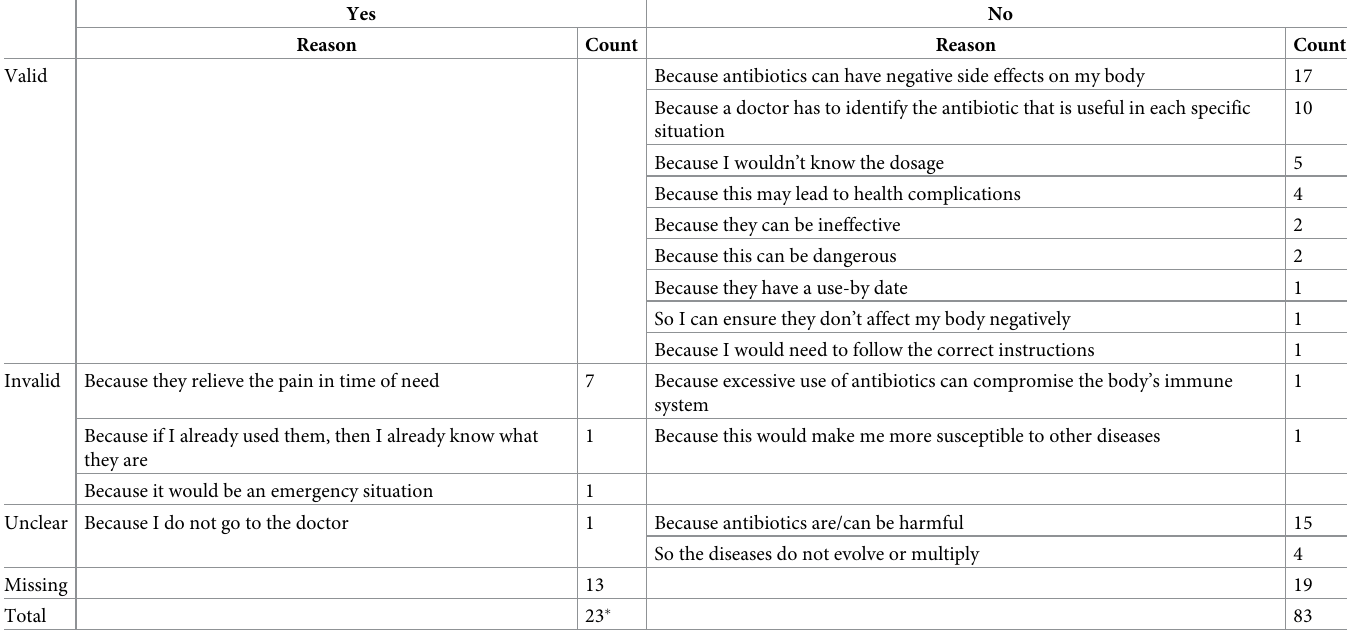
Table 3. Findings pertaining to Question 2: Would you take antibiotics without a prescription? Why/Why